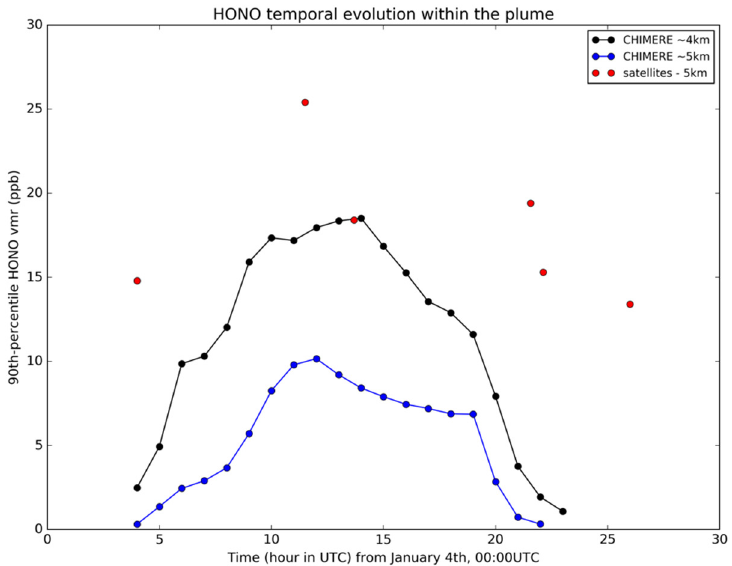
Figure 8. Temporal evolution of HONO simulated at ~4 km (black) and ~5 km (blue) by CHIMERE and observed by satellite instruments. The vmrs correspond to the 90th-percentile of the HONO vmr within the plume.